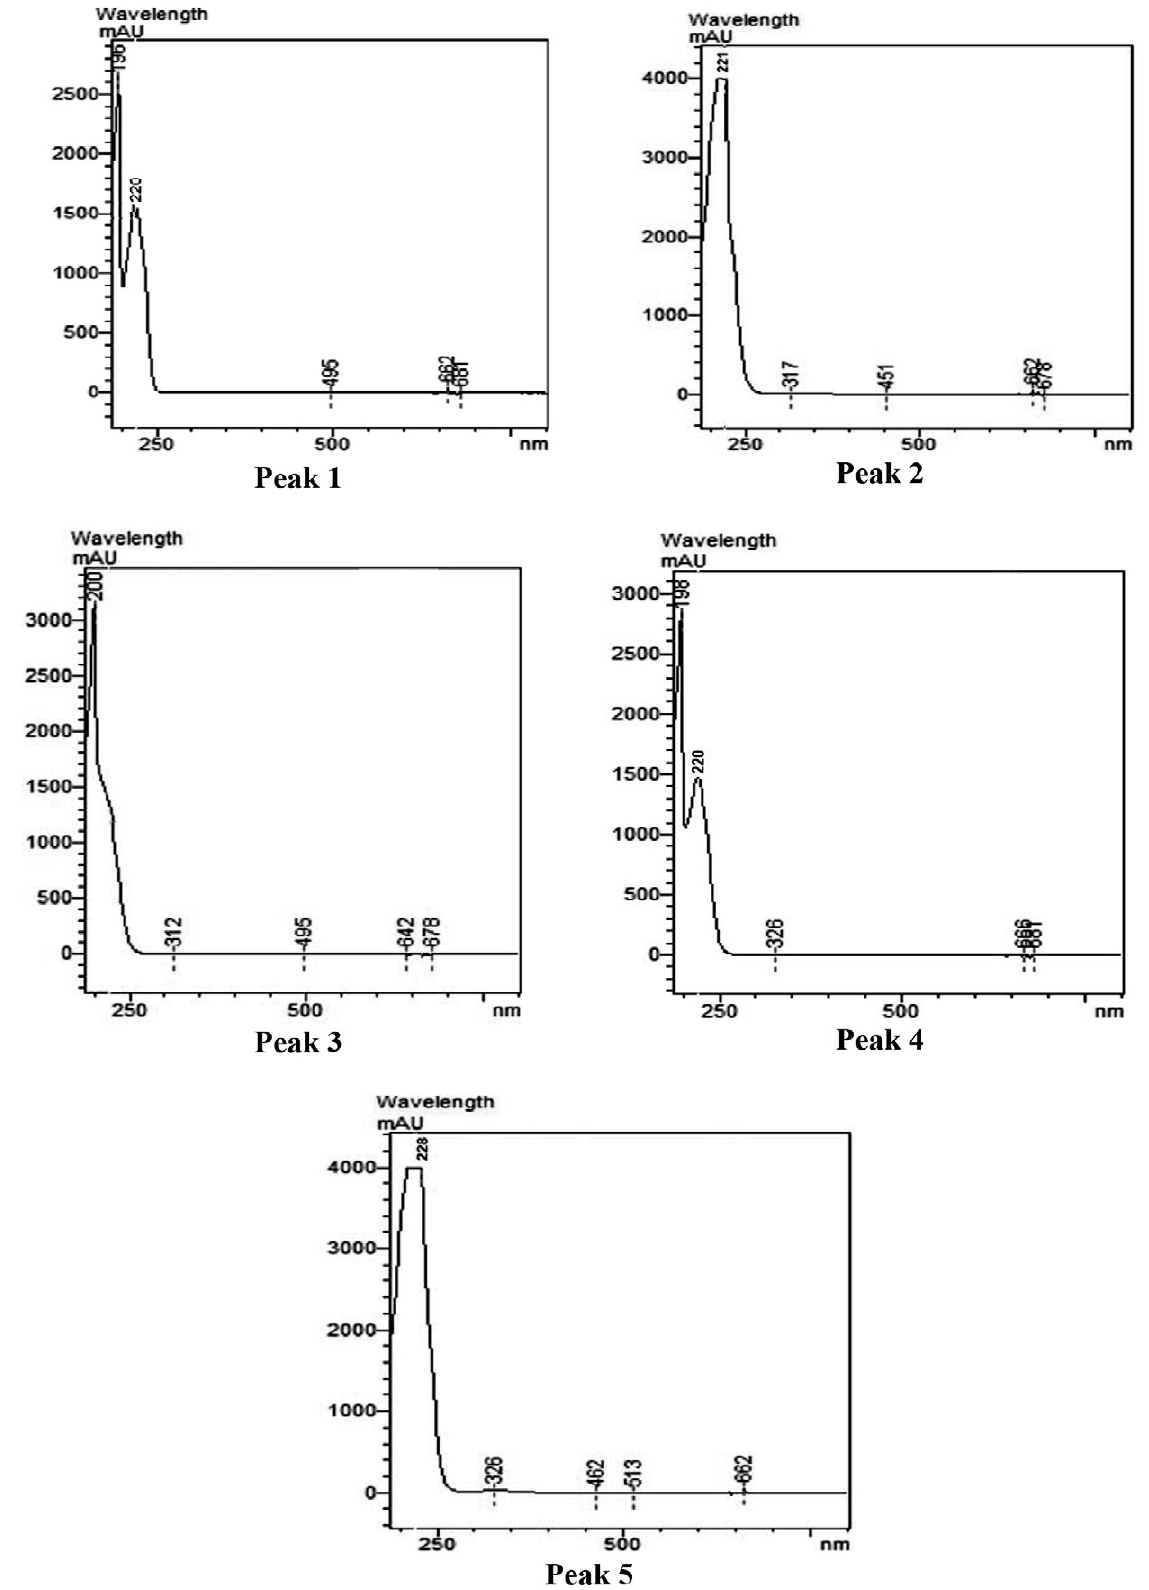
Figure 2. Absorption spectra of compounds corresponding to five peaks chromatographed using dichloromethane dry extract dissolved in methanol and water 50:50